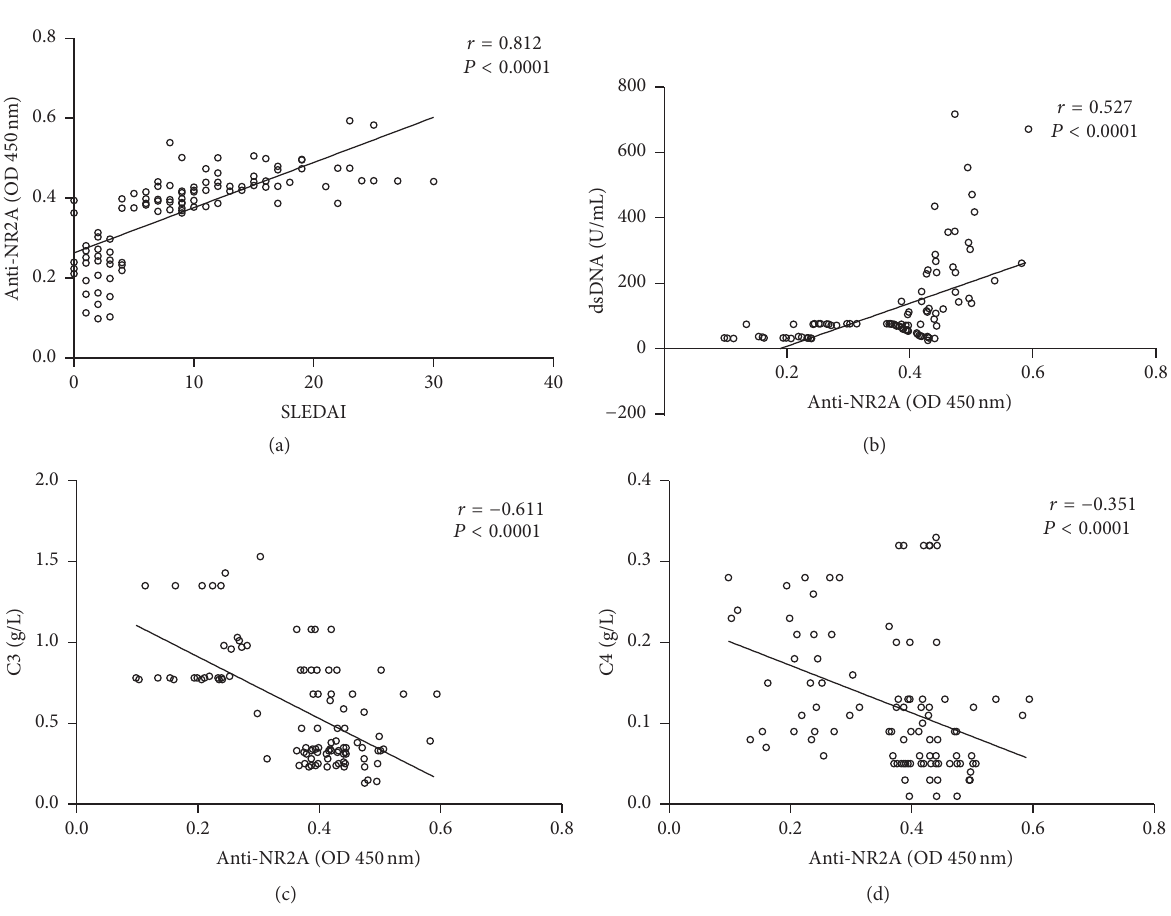
Figure 3: Correlations of anti-NR2A with anti-dsDNA antibodies, C3, C4, and SLEDAI in SLE